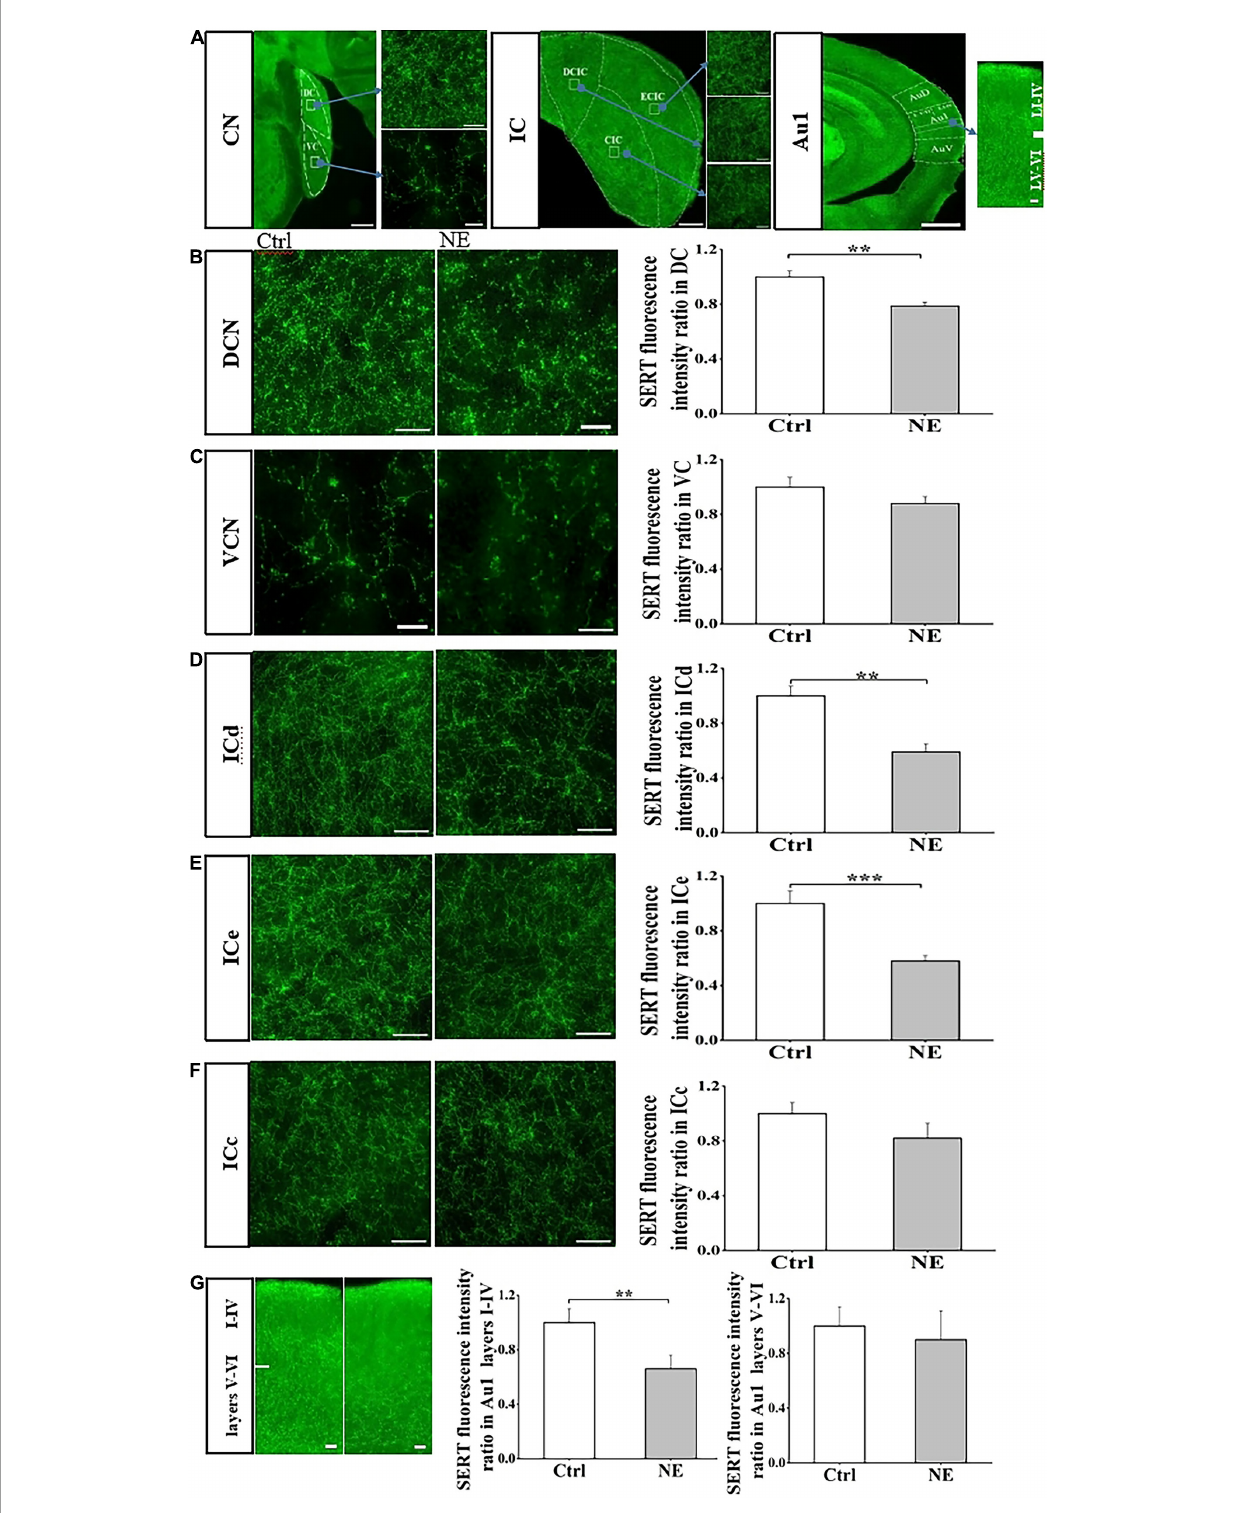
FIGURE3 Noise exposure decreased SERT level in auditory brain subregions. (A) The photomicrographs taken with a 20 × and 40 × magnification illustrate SERT immunoreactivity in the cochlear nucleus (CN), inferior colliculus (IC), primary auditory cortex (Au1), and their subregions dorsal CN (DCN), ventral CN (VCN), dorsal IC (ICd), external IC (ICe), central (ICc), Au1 layers I-VI. (B–G) Left: Micrograph taken with a 40 × magnification show the distribution of SERT + fibers in the DCN, VCN ICd, ICe, ICc, and Au1 layers I-VI. Right: Bar graphs represent the SERT immunofluorescence intensity ratio in these subregions between NE and Ctrl groups. A quantitative immunofluorescence ratio was calculated by dividing SERT immunofluorescence intensity in NE, 15dPNE, 30dPNE groups by that in the Ctrl group. Values are mean ± SE, data was analyzed by Student’s t -tests. Ctrl group n = 7; NE group n = 7. Statistical difference is represented as * p < 0.05, ** p < 0.01, *** p < 0.001 for comparisons between the Ctrl group and NE